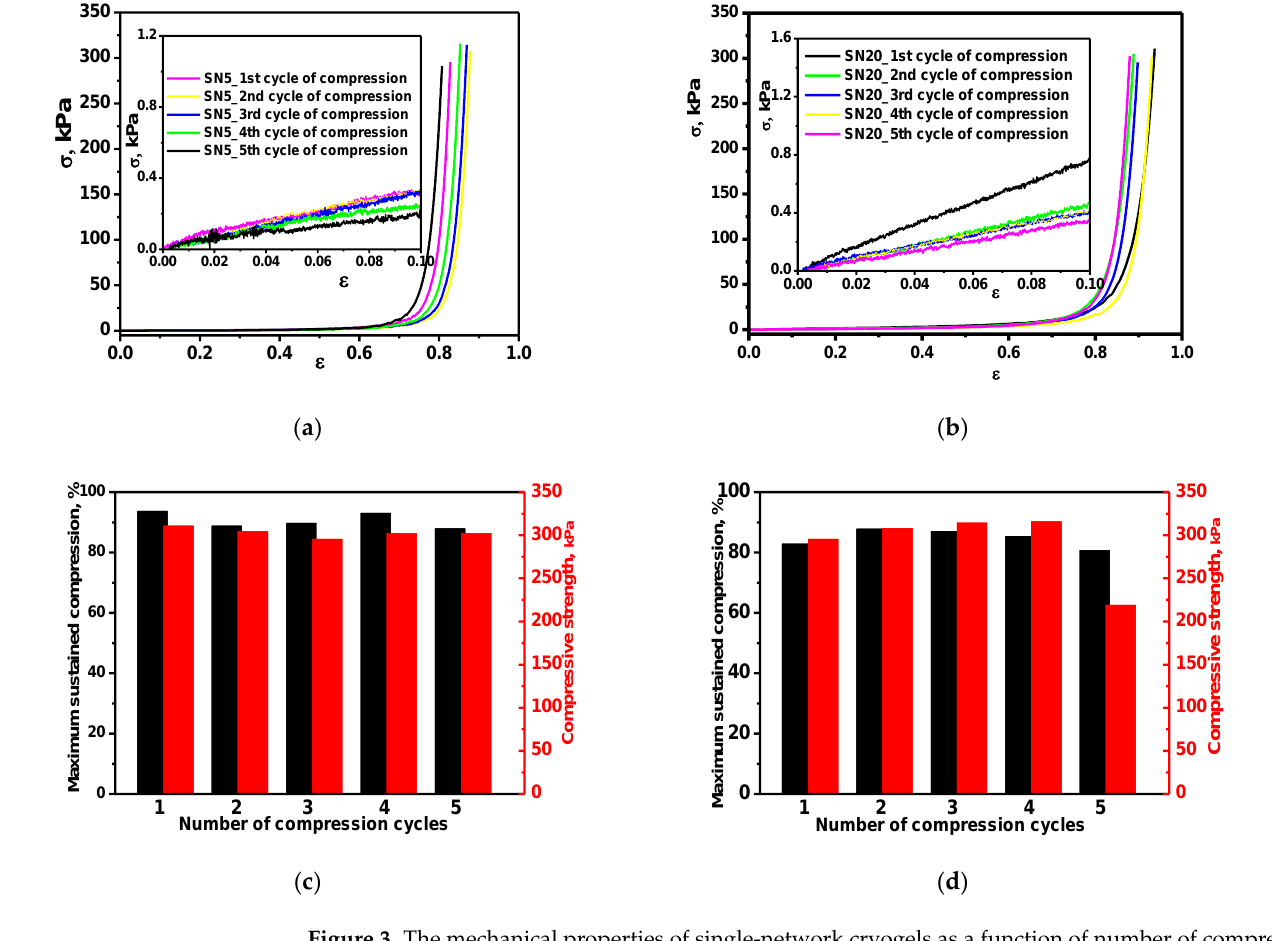
Figure 3. The mechanical properties of single-network cryogels as a function of number of compression cycles. Stress – strain profiles of SN5 ( a ) and SN20 ( b ) cryogels (the insets of ( a , b ) present the linear dependence of stress – strain curves used for the calculation of compression elastic moduli). Maximum sustained compression (black column bars) and compressive strength (red column bars) for SN5 ( c ) and SN20 ( d ) cryogels.